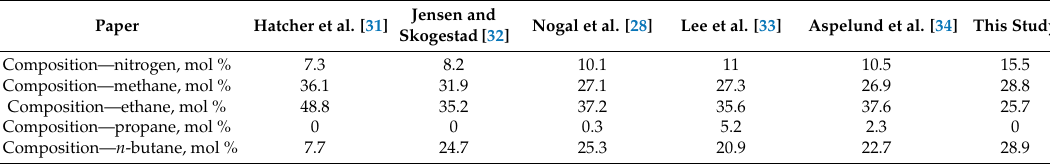
Table 10. Comparison of optimal refrigerant compositions.